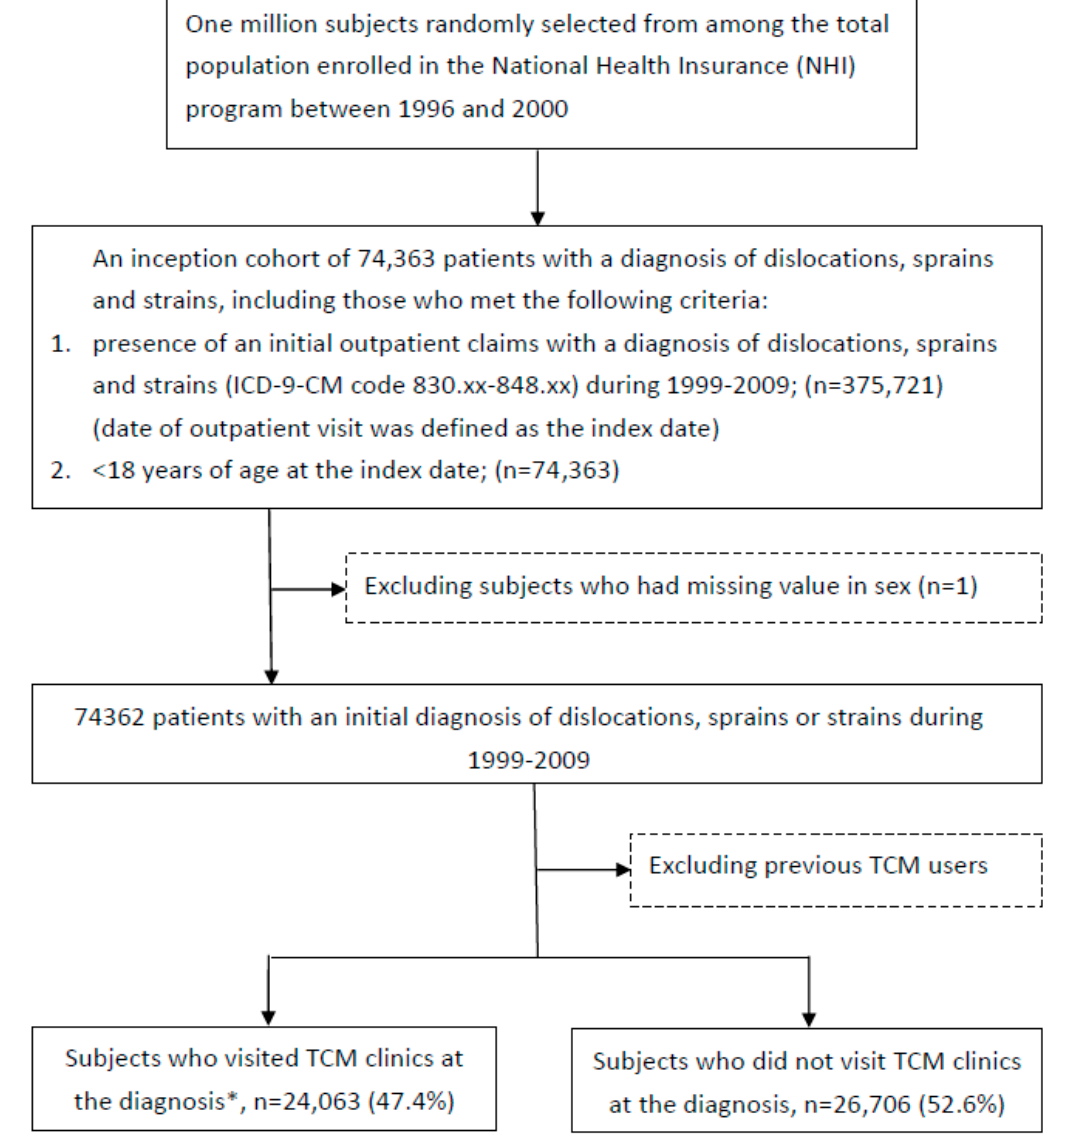
Figure 1. Flowchart of the selection of study subjects.